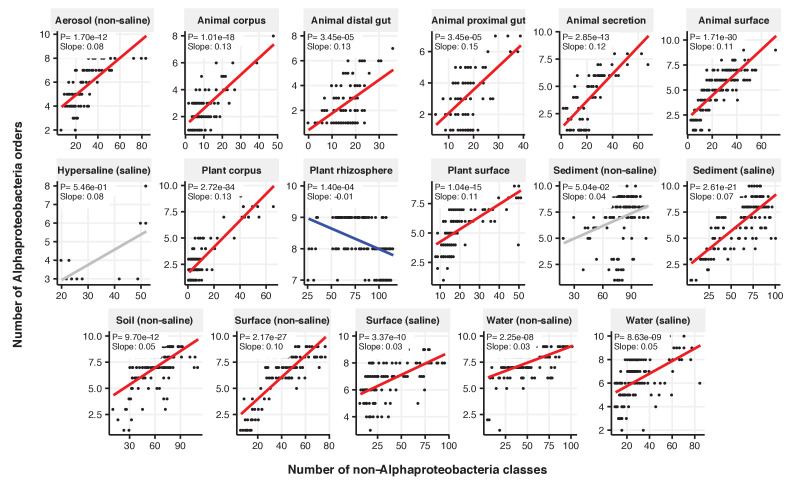
Focal-lineage diversity as a function of community diversity across biomes in Alphaproteobacteria.Linear models are shown for the number of orders per class (y-axis) as a function of community diversity (non-focal classes, x-axis) in each of the 17 environments (EMPO3 biomes). Only environments containing the focal lineage are shown. Significant positive diversity slopes are shown in red, negative in blue (linear models, p<0.05, Bonferroni corrected for 17 tests), and non-significant in grey.